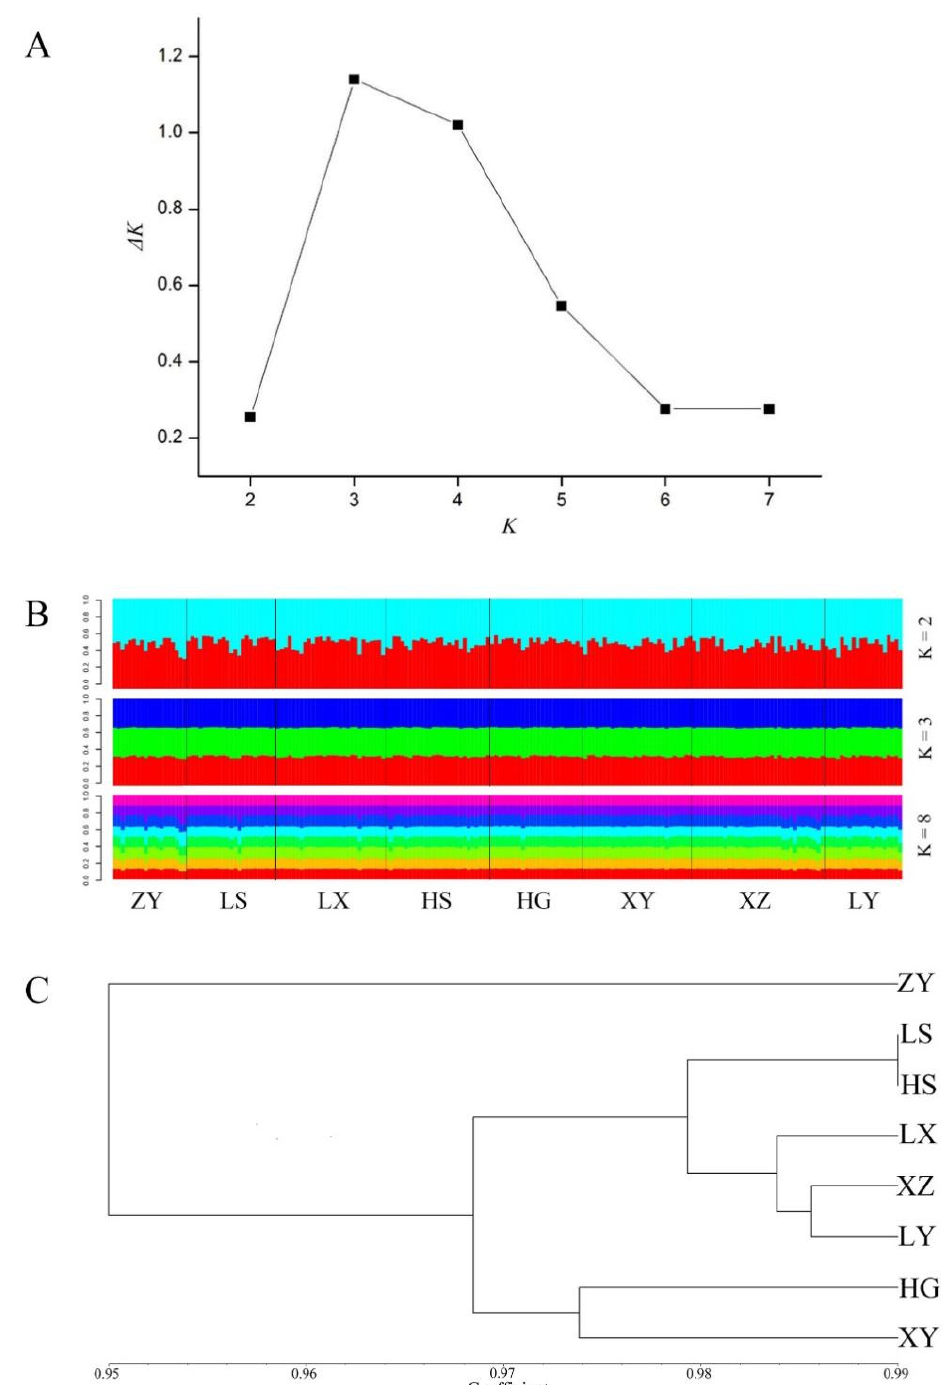
Figure 3. Genetic structure of eight T. sebifera populations. ( A ) Relationship between the number of clusters (K) and the corresponding ∆ K statistic; ( B ) Results of the structure analysis of T. sebifera populations when K = 2, 3, and 8. Different colors (light-blue, red, blue, green, dark purple, pur- ple, light-green, and orange) represent different genetic compositions; ( C ) Cluster diagram of the eight